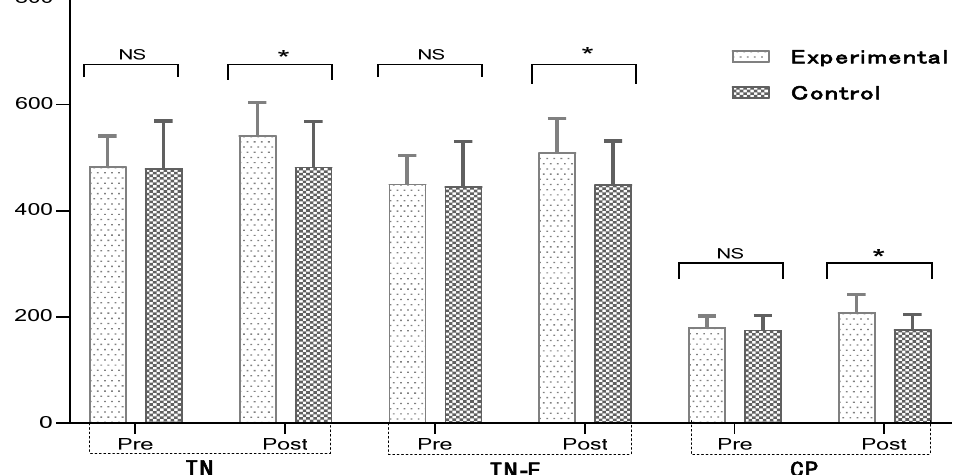
Figure 4. The comparison of the pretest and posttest attention scores between groups. * p < 0.05, NS: non-significant, Pre: pre-test, Post: posttest, TN: total number of marked items, TN-E: total item number − total error, CP: concentration performance, number of correctly marked items.